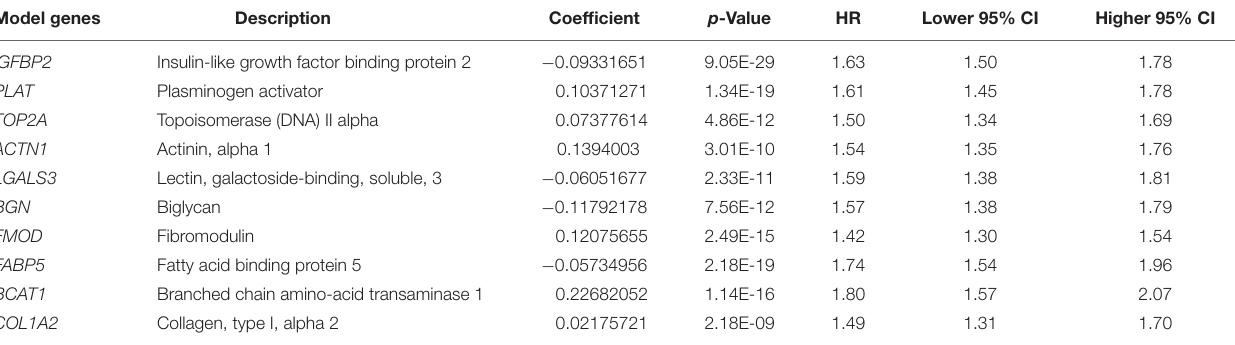
TABLE 2 | Detailed information of model genes.